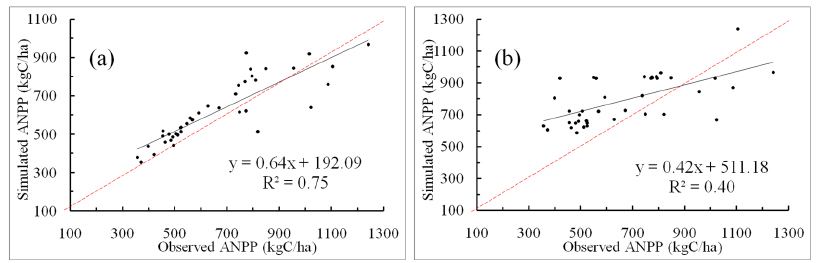
Figure 4. Comparison of ANPP between the field data and the model estimation ( a ) with considering grazing and ( b ) without considering grazing in Zoige County.